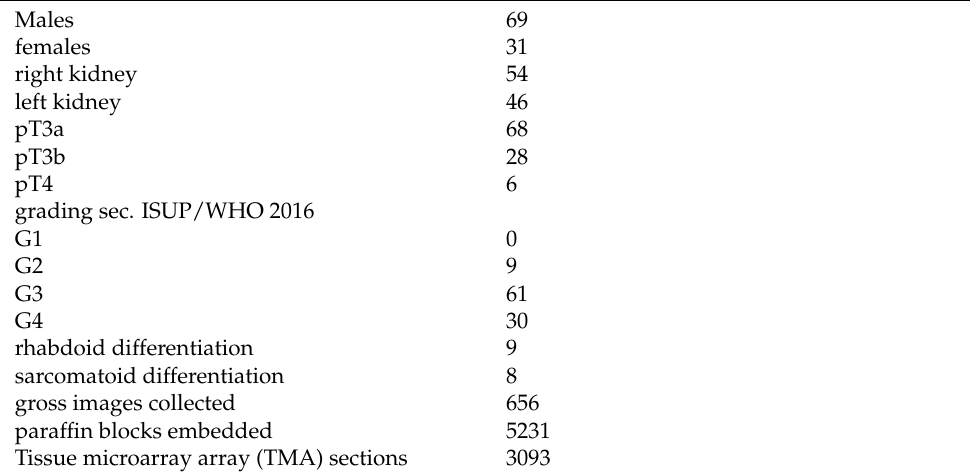
Table 1. Clinicopathological findings in 100 advanced ≥ pT3a staged